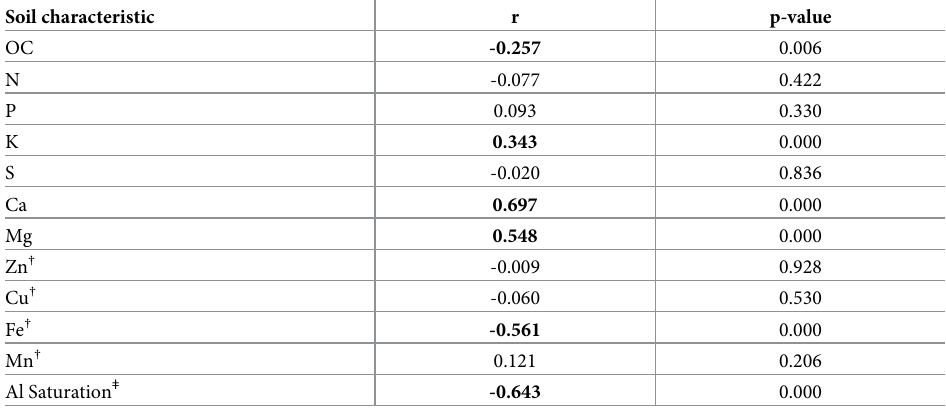
Table 7. Correlations between soil pH and various soil chemical characteristics on crop fields (n = 112). Soil characteristic